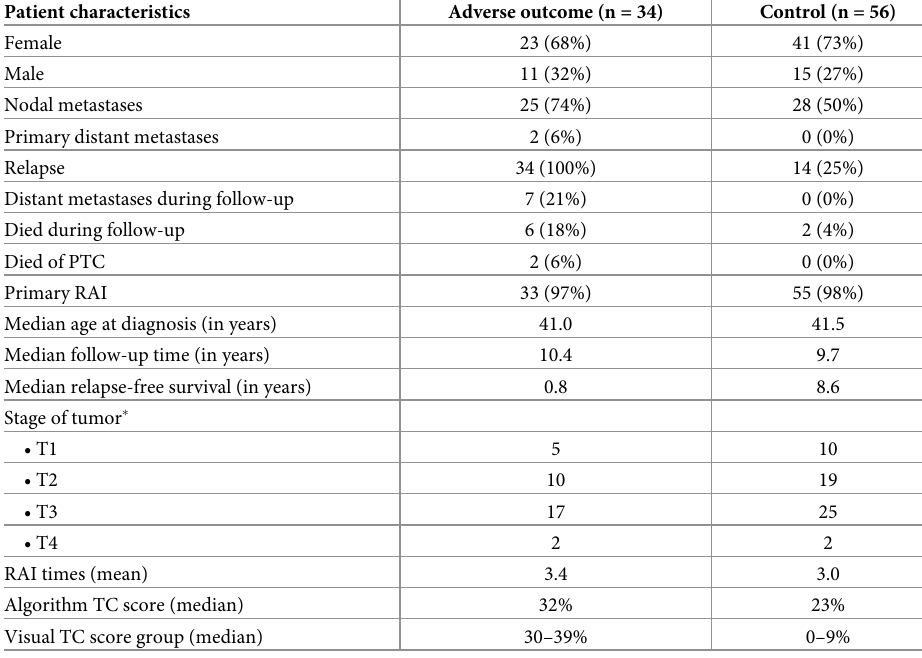
Figures represent number of patients unless otherwise stated RAI, radioiodine ablation � T classification and TNM stage according to the TNM classification, seventh edition of the American Joint Committee on Cancer staging of papillary thyroid